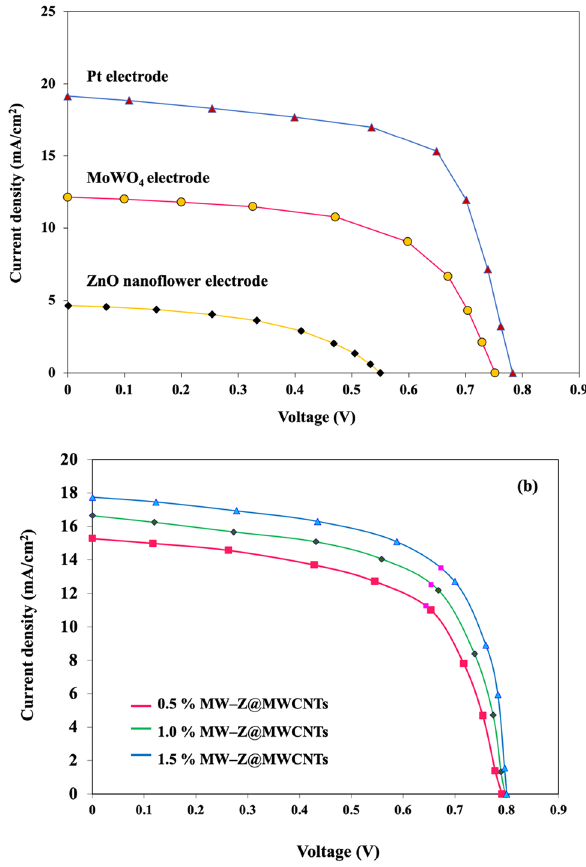
Figure 9. Current–voltage characteristics of DSSCs with different Ces.